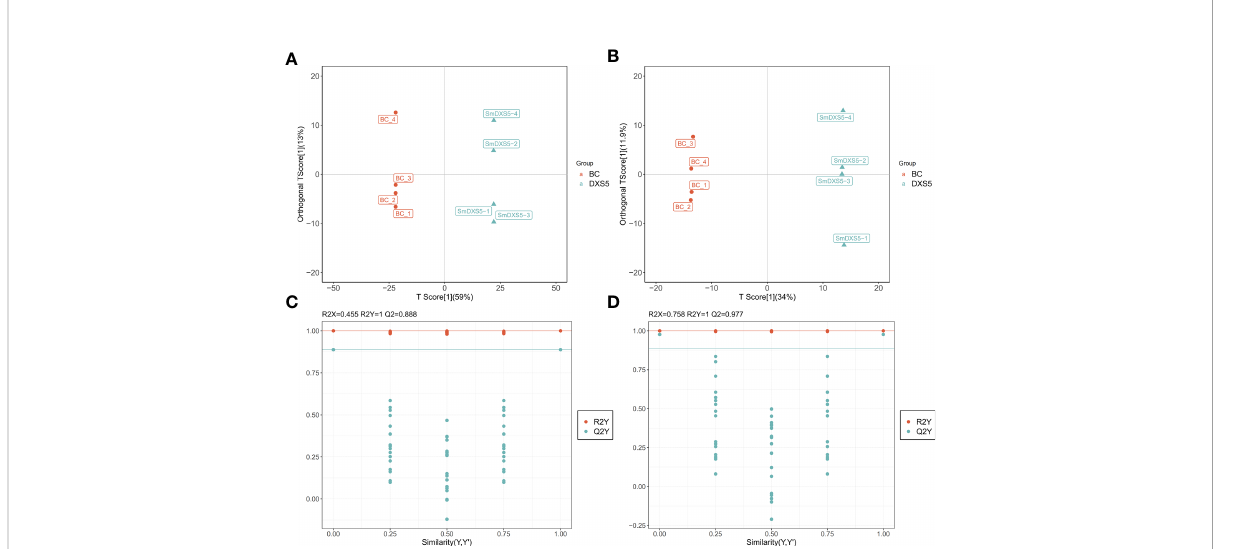
FIGURE 3 Orthogonal partial least squares-discriminant analysis (OPLS-DA) and 200-response sorting tests of the OPLS-DA model. (A) , (C) Positive ion mode. (B) , (D) Negative ion mode. The 200-response sorting tests of the OPLS-DA model, Q2 is an important parameter for evaluating the OPLS-DA model, and the R2X and R2Y represent the percentage of OPLS-DA model that can explain X and Y matrix information,